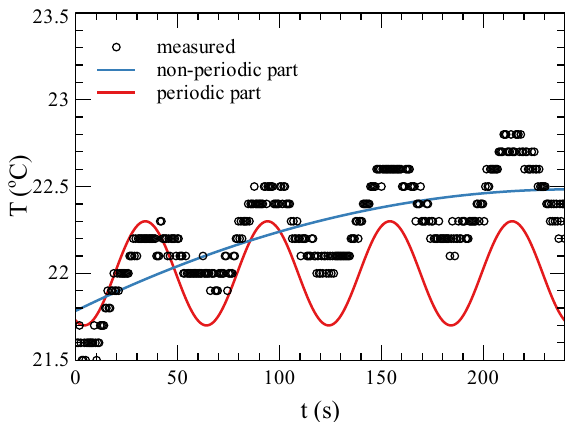
Figure 10. Record of measured surface temperatures with periodic and non-periodic component shown. The phase difference of the transmitted signal and the surface temperature corresponds (phase delay) to about 17 ◦ , which corresponds to the heat transfer coefficient about 850 W/m 2